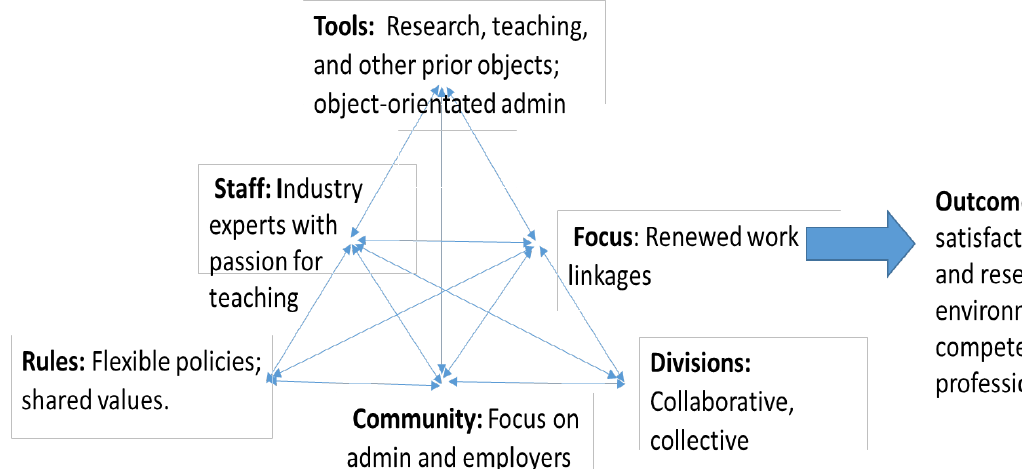
Figure 4 : Activity system of the future with new single